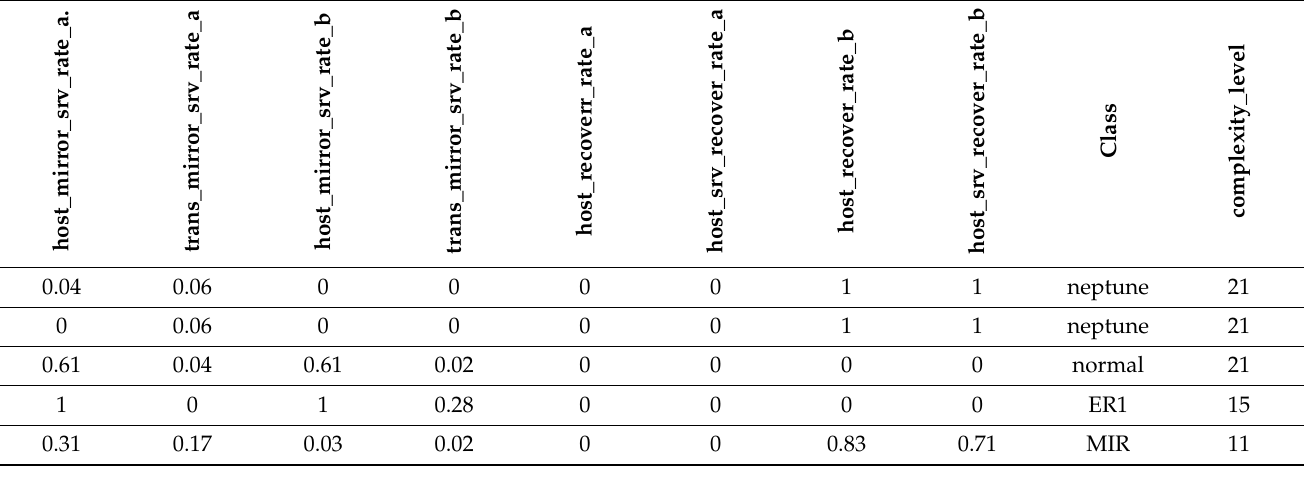
Table 8. Mirroring and erasure coding.